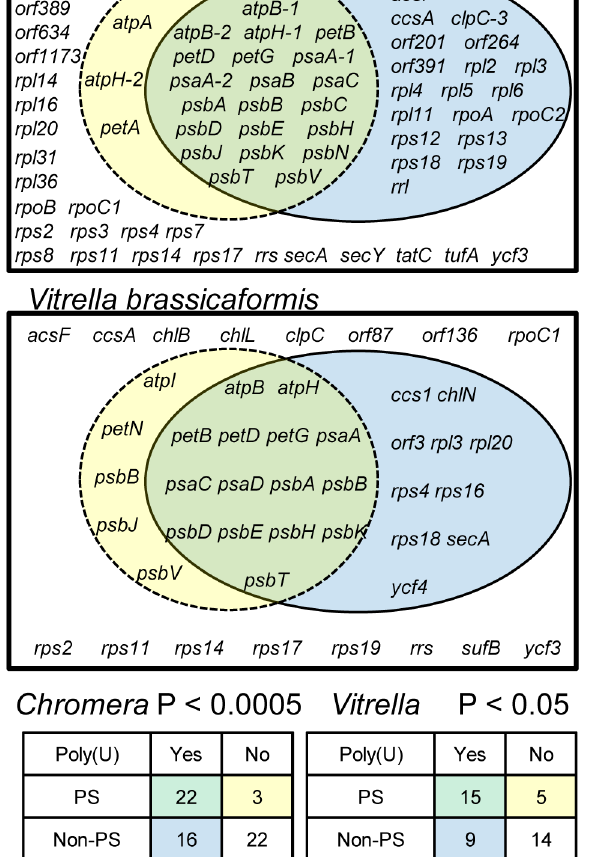
Figure 2. The total distribution of poly(U) sites across chromerid chloroplasts. The Venn diagrams show the total results of oligo-d(A) RT-PCRs for genes from C. velia and V. brassicaformis . Chi- squared distributions and P values for the significance of association between photosynthesis function and presence of an associated poly(U) site are shown at the bottom of the diagram.